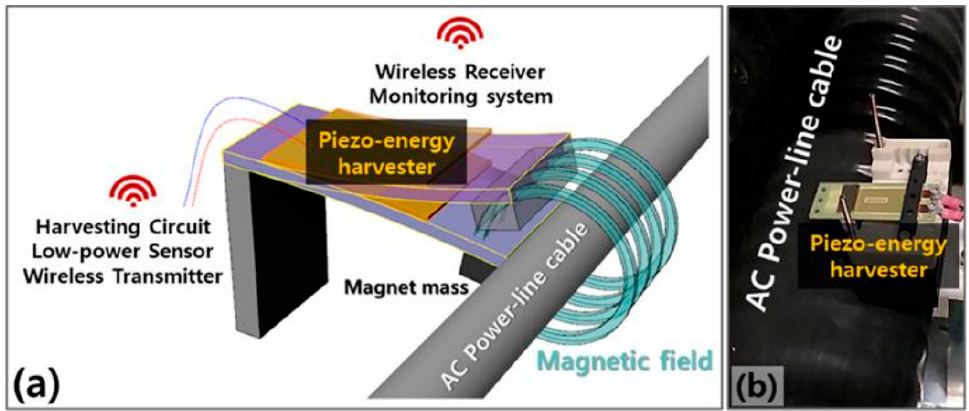
Figure 1. ( a ) Schematic of the magnetic field energy harvesting process using the piezo-energy harvester. ( b ) Photograph of the piezo-energy harvester for scavenging the magnetic field of AC power-line cable.